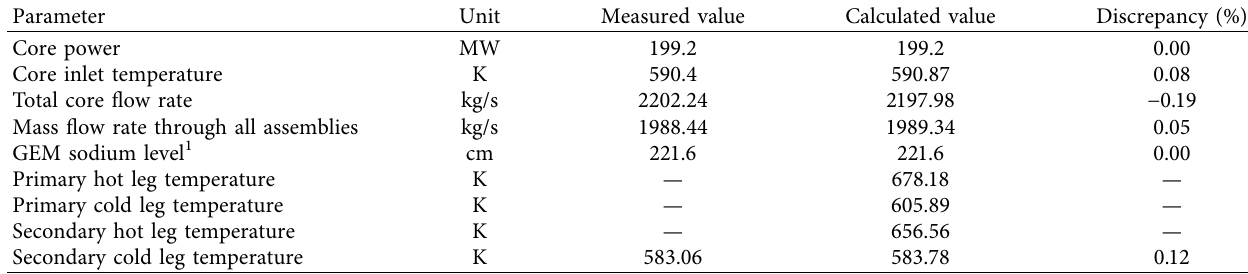
Table 5: Comparison of benchmark and SAC-3D steady-state parameters.